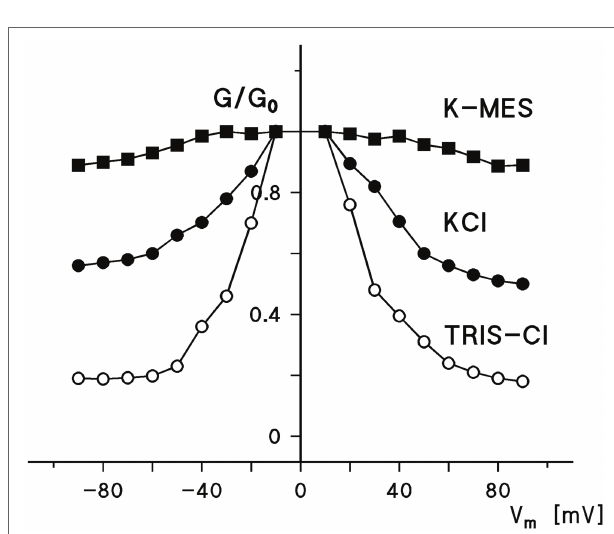
FIGURE 2 | Ratio of the conductance, G, at a given voltage, V m , divided by the conductance, G 0 , at 10 mV as a function of the voltage. The aqueous phase contained either 0.5 M KCI, 0.5 M K-MES, or 0.5 M TRIS-HCI (pH in all cases 7.2). The cis-side contained about 10 ng/ml hVDAC1 [Porin 31 HL (Benz et al., 1992)]. The sign of the voltage is given with respect to the cis- side, the side of the addition of Porin